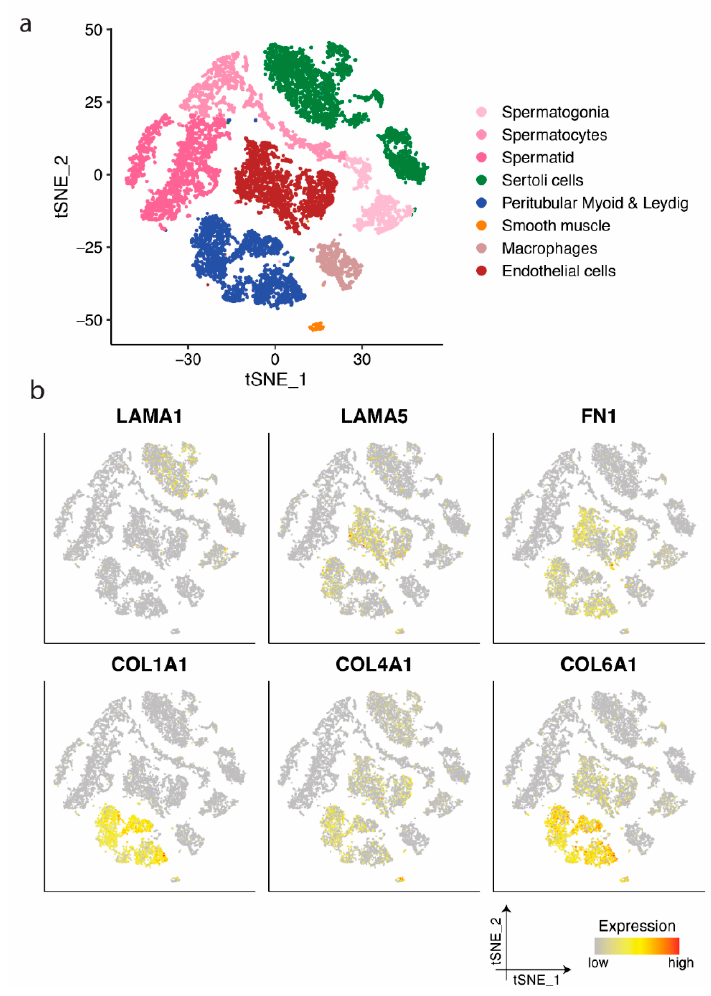
Figure 3. Identification of cell clusters and single-cell transcription profiles of postnatal testicular cells. ( a ) The t-SNE plot of germ and somatic cells, coloured by the identified cell types. ( b ) Single-cell expression profile for ECM protein coding genes exhibited on the t-SNE plot; gradient of grey, yellow, orange, and red indicates low to high